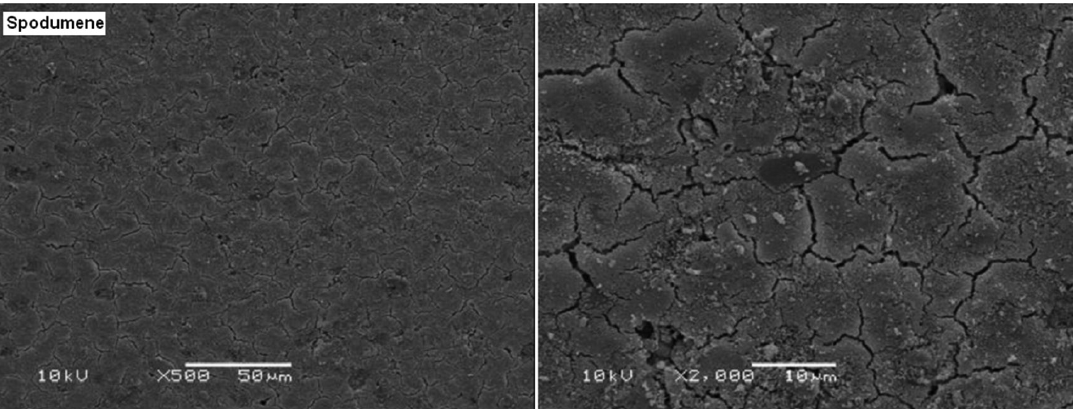
Figure 6. Images (SEM): chemical etching (20%HF, 20 s); Spodumene body fired at 1240